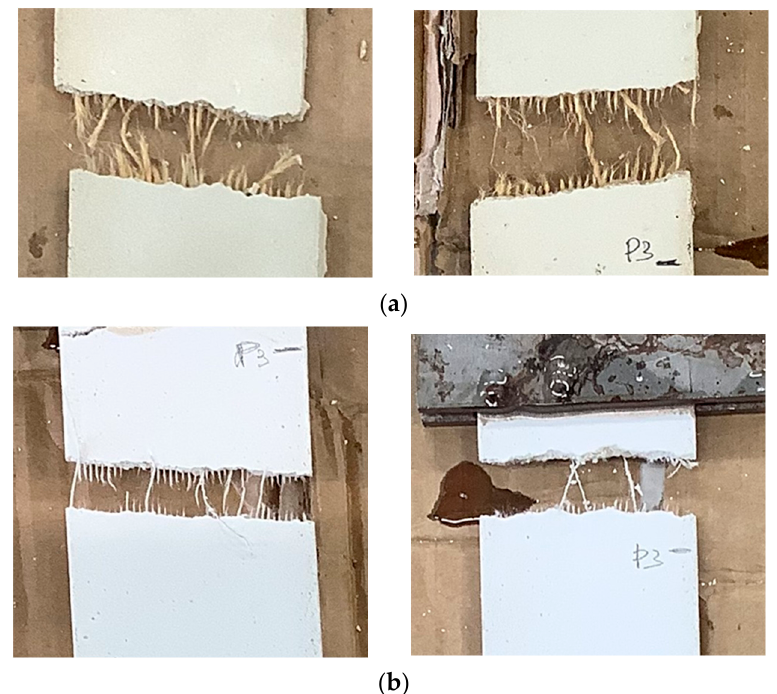
Figure 17. Example of Jute-TRM ( a ) and Flax-TRM ( b ) break. Comparisons in Terms of TRM Strength